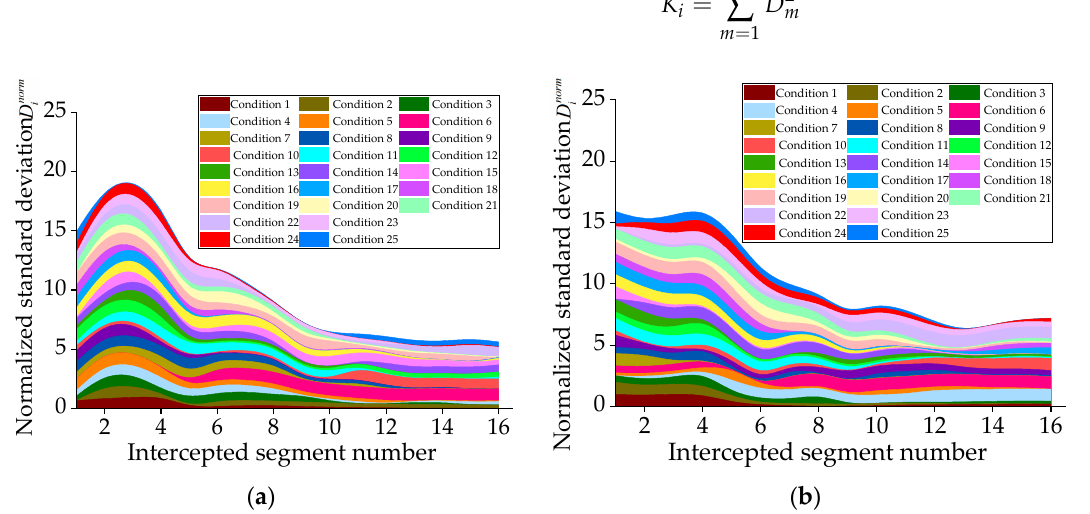
Figure 15. Normalized standard deviation D norm Results for two-span continuous gird bridge; ( b ) Results for three-span continuous gird bridge.